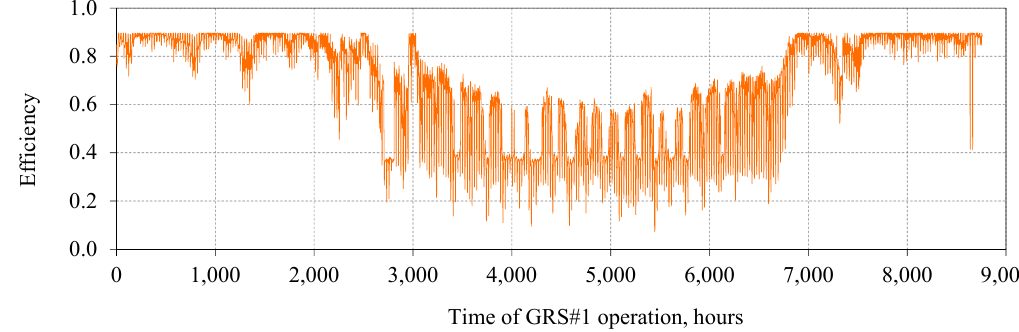
Figure 8. Generated electrical energy and heat demand at GRS #1 over a period of one year.